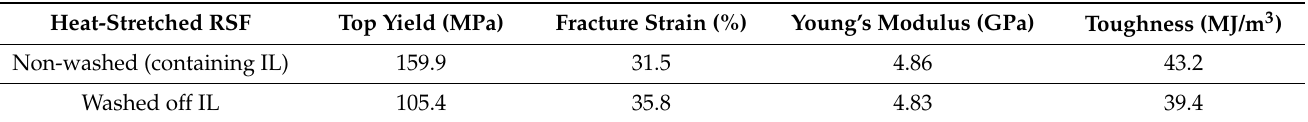
Figure 5. Stress–strain (S–S) plots for heat-stretched regenerated silk fibroin (RSF) fibers. Closed circles ( • ) represent S–S plots of heat-stretched RSF without wash using methanol. Open squares ( (cid:3) ) represent S–S plots of heat-stretched RSF after wash using methanol. Table 1. Mechanical property values of heat-stretched regenerated silk fibroin (RSF) fibers on the tensile